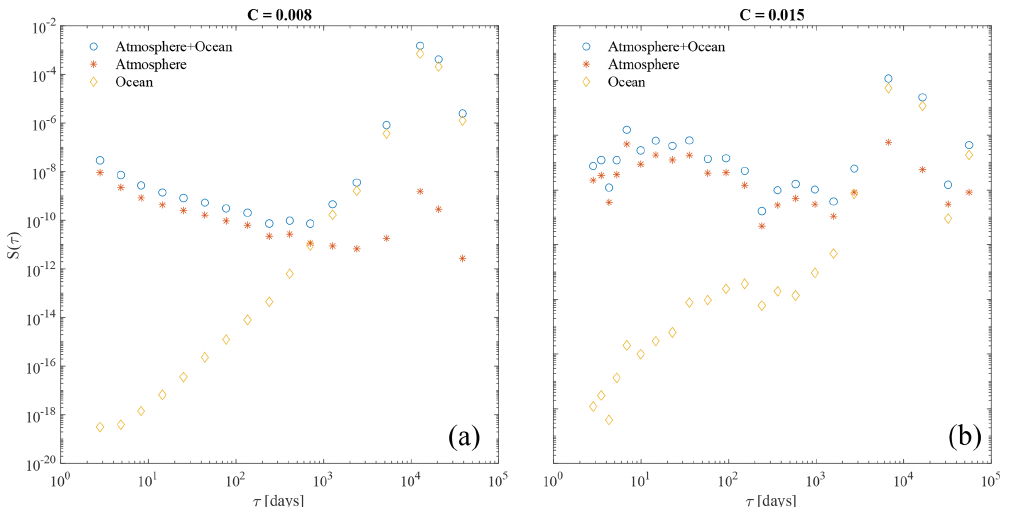
Figure 2. Spectral energy content S ( τ ) of the different MIMFs as a function of their mean timescales τ as in Eq. (7) for the full system (atmosphere + ocean, blue circles), only for the atmosphere (orange asterisks), and only for the ocean (yellow diamonds). Panel (a, b) refer to the two values of the friction coefficient, C = 0 . 008 and C = 0 . 015,